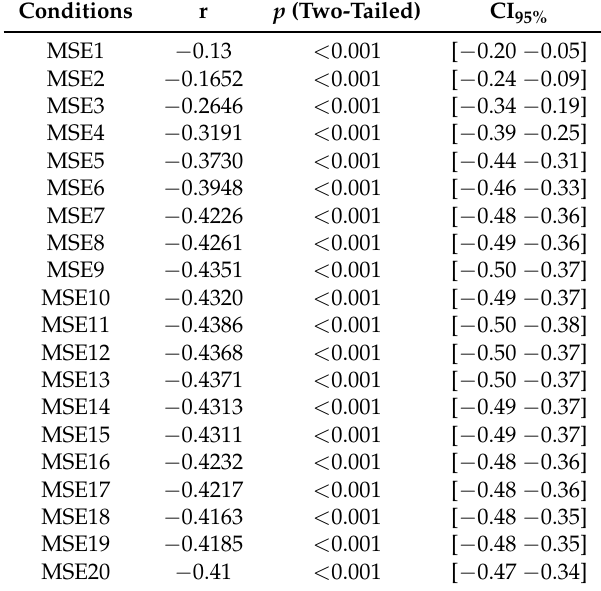
Table A9. Bootstrap (10,000 simulation runs) 95.0% confidence intervals (CI) associated with the Spearman correlation between MSE1s (i.e., 62 MSE1s associated with 62 EEG channels of a participant, per affect) through MSE20s (i.e., 62 MSE20s associated with 62 EEG channels of a participant, per affect) and DEs (i.e., 62 DEs associated with 62 EEG channels of a participant, per affect) in the positive mental